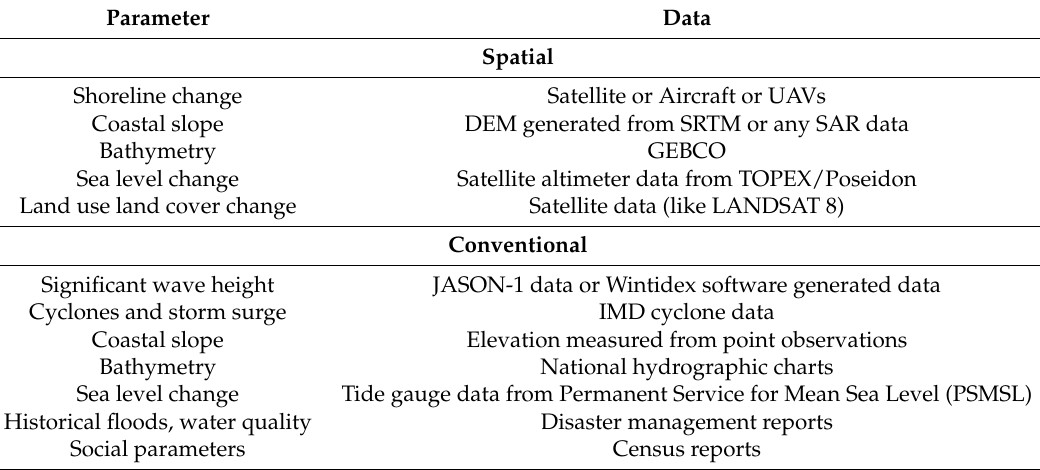
Table 2. Different types of data that can be used for CVI studies in